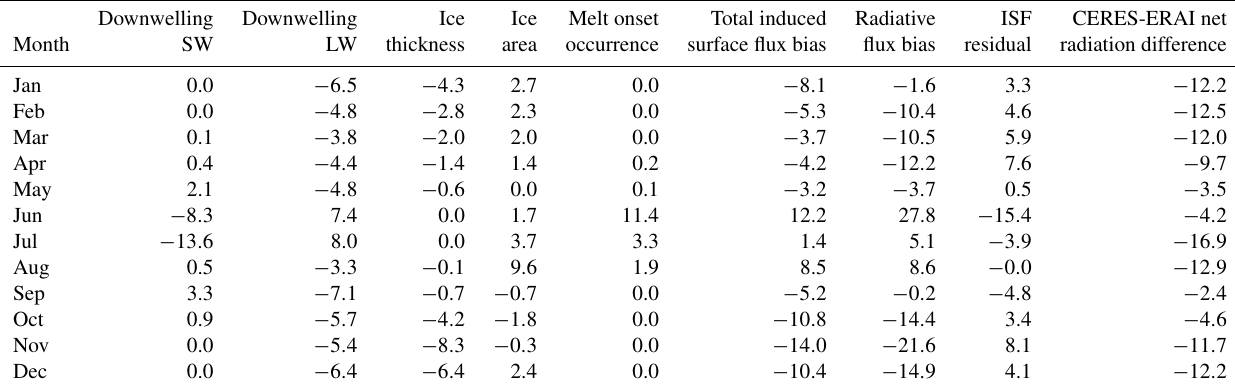
Table 1. Surface flux biases induced by model bias in five different variables in HadGEM2-ES (Wm − 2 ), with CERES used as reference dataset for the radiative components. Total ISF bias and total net radiative flux bias relative to CERES are shown for comparison, as well as their residual. The difference between net radiative flux bias as evaluated by CERES and ERAI is also shown. A positive number denotes a downwards flux, and vice